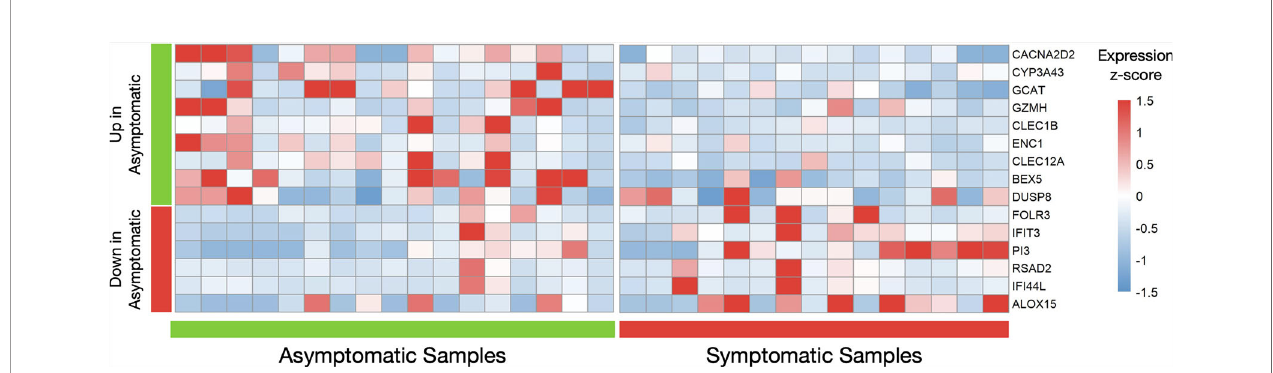
FIGURE 2 | Differential gene expression analysis in seropositive healthy individuals with prior asymptomatic or clinical SARS-CoV-2 infection. Heatmap of robustly differentially expressed genes (genes that were differentially expressed and highly expressed in three or more samples, logFC>|1|, meta p-value<0.05) in individuals with prior asymptomatic infection relatively to those with clinical ( “ symptomatic ” ) SARS-CoV-2 infection, with raw expression values being scaled. The values for all samples (17 asymptomatic on the left and 15 clinical on the right) is plotted. The fi rst nine genes are increased in the Asymptomatic group, while the next six are decreased.